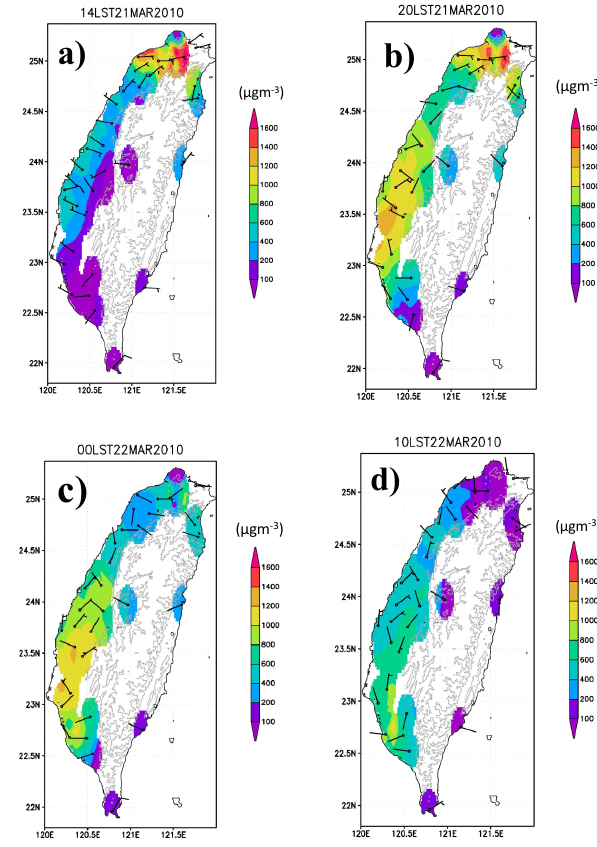
Fig. 3. Spatial distribution of observation PM 10 (µgm − 3 ) concen- tration and wind recorded in Taiwan at (a) 14:00LST, 21 March (b) 20:00LST, 21 March (c) 00:00LST, 22 March (d) 10:00LST, 22